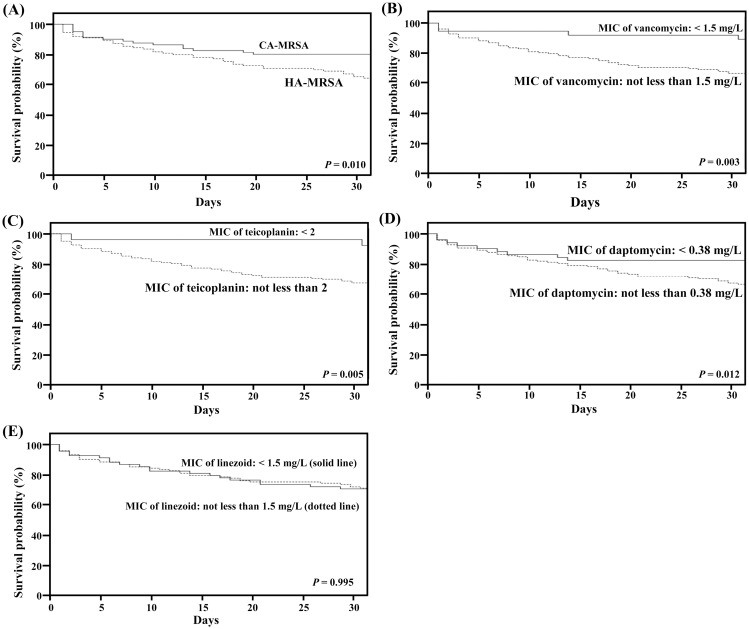
The Kaplan-Meier estimate of survival curves of patients with methicillin-resistant Staphylococcus aureus (MRSA) bacteremia.The Kaplan-Meier survival curve of patients infected by community-associated MRSA (solid line) is compared with those by hospital-associated MRSA (dotted line) (P < 0.010, by log-rank test) (A). The Kaplan-Meier survival curve of patients infected by MRSA with vancomycin minimum inhibitory concentration (MIC) ≥ 1.5 mg/L (dotted line) is compared with those by MRSA with vancomycin MIC < 1.5 mg/L (solid line) (P = 0.003, by log-rank test) (B). The Kaplan-Meier survival curve of patients infected by MRSA with teicoplanin MIC ≥ 2 mg/L (dotted line) is compared with those by MRSA with teicoplanin MIC < 2 mg/L (solid line) (P = 0.005, by log-rank test) (C). The Kaplan-Meier survival curve of patients infected by MRSA with daptomycin MIC ≥ 0.38 mg/L (dotted line) is compared with those by MRSA with daptomycin MIC < 0.38 mg/L (solid line) (P = 0.012, by log-rank test) (D). The Kaplan-Meier survival curve of patients infected by MRSA with linezolid MIC ≥ 1.5 mg/L (solid line) is compared with those by MRSA with linezolid MIC < 1.5 mg/L (dotted line) (P < 0.995, by log-rank test) (E).